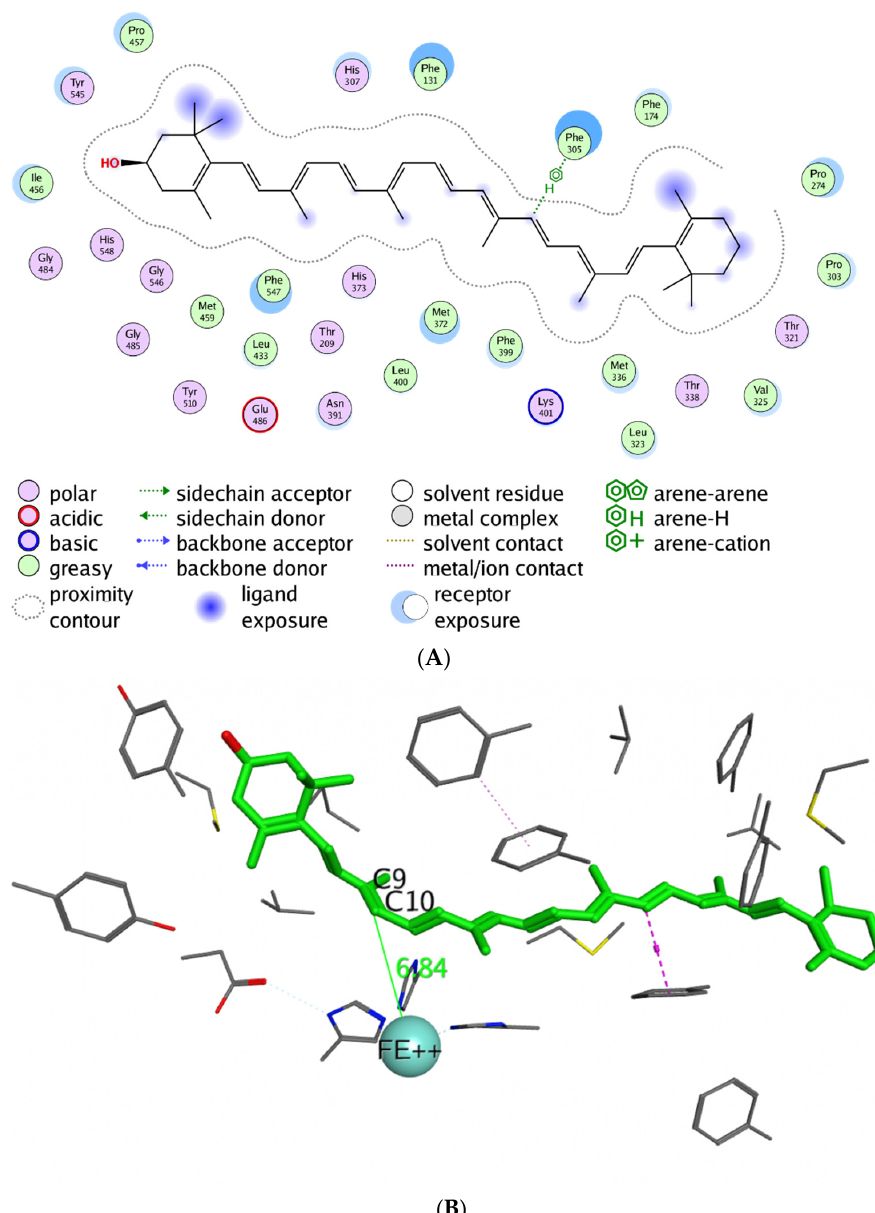
Figure 6. ( A ) 2D representation of the interactions established by β -cryptoxanthin within the CCD4b catalytic site. Only the residues contacting the carotenoid at less than 4.5 Å distance are shown. ( B ) 3D representation of the interactions in which the catalytic Fe +2 ion is represented by a cyan sphere. The model of CCD4b inserted in the membrane, at the end of the 20 ns molecular